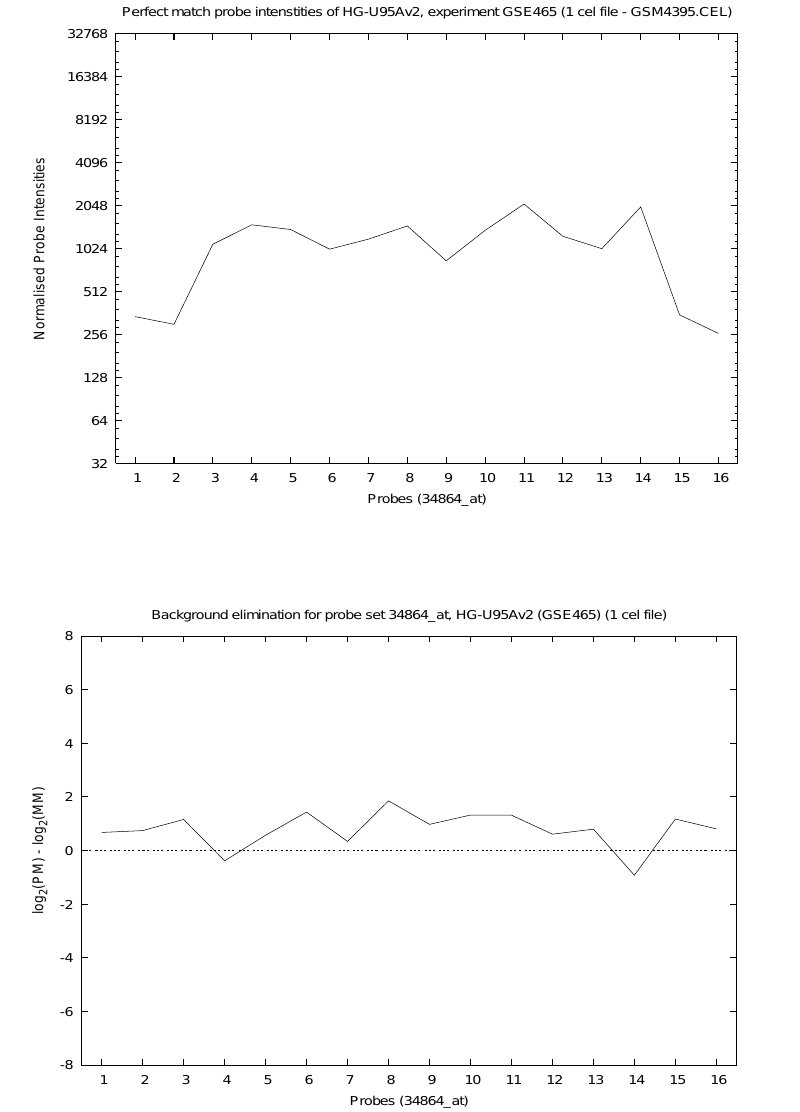
Figure 6: Probe intensities for experiment GSE465 of probe set 34864 at on the HG U95Av2 array (A) Perfect match intensities (log scale) (B) Background elimination (log 2 (PM) - log 2